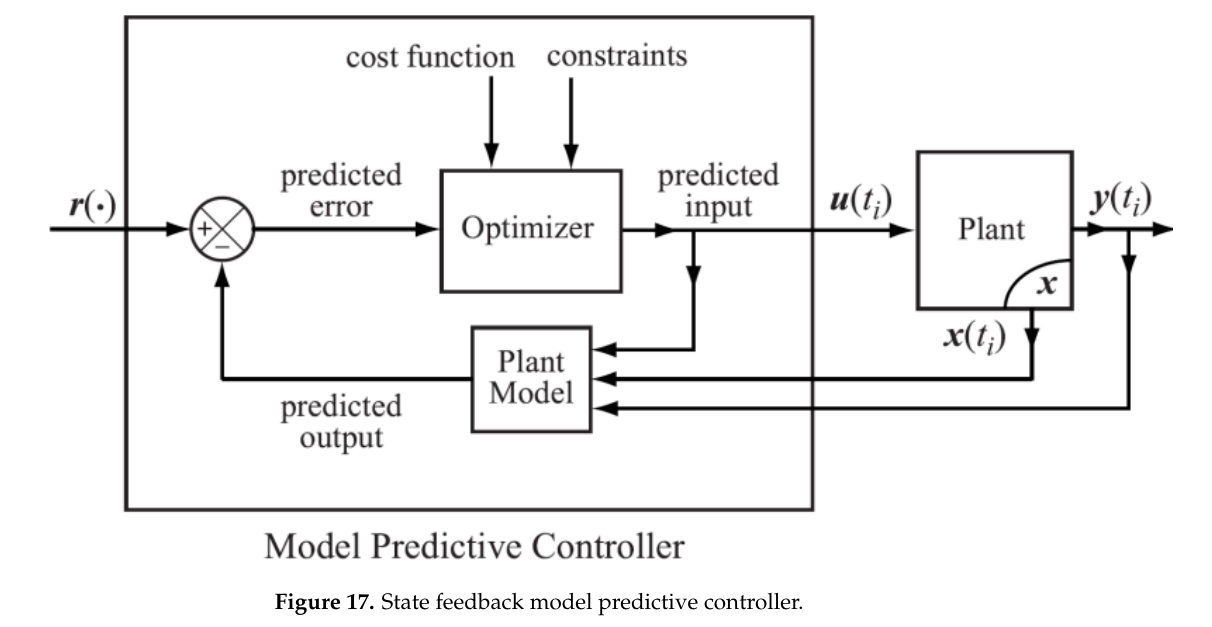
Figure 17. State feedback model predictive